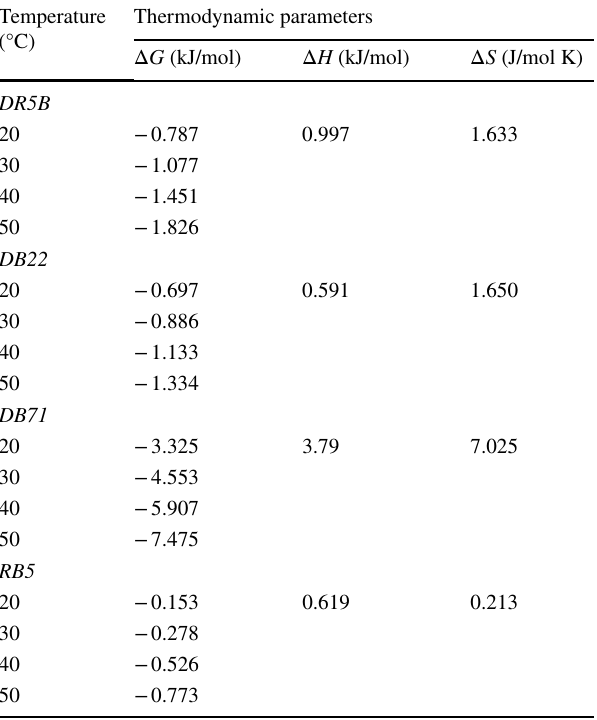
Table 3 Thermodynamic analysis for the adsorption of DR5B, DB22, DB71, and RB5 onto spent mushroom waste at different temperatures Temperature (°C)